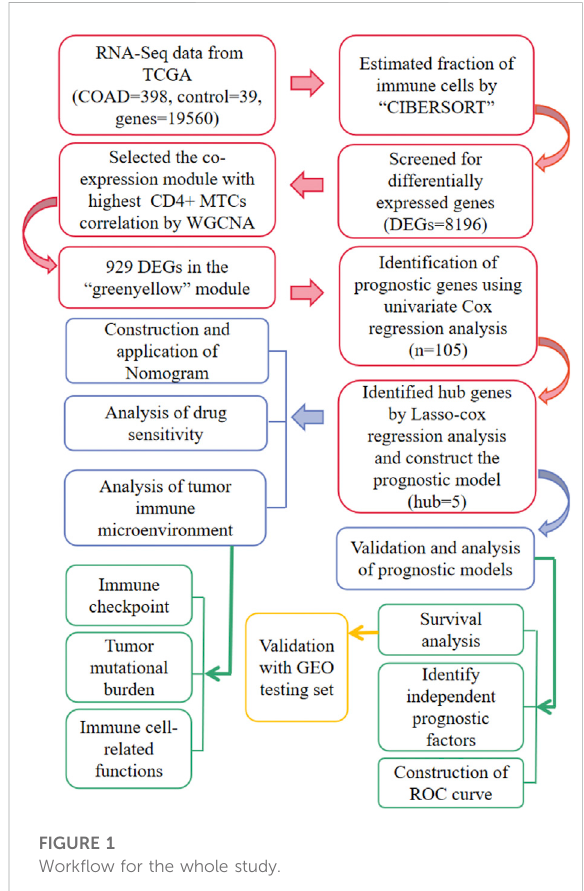
FIGURE 1 Work fl ow for the whole